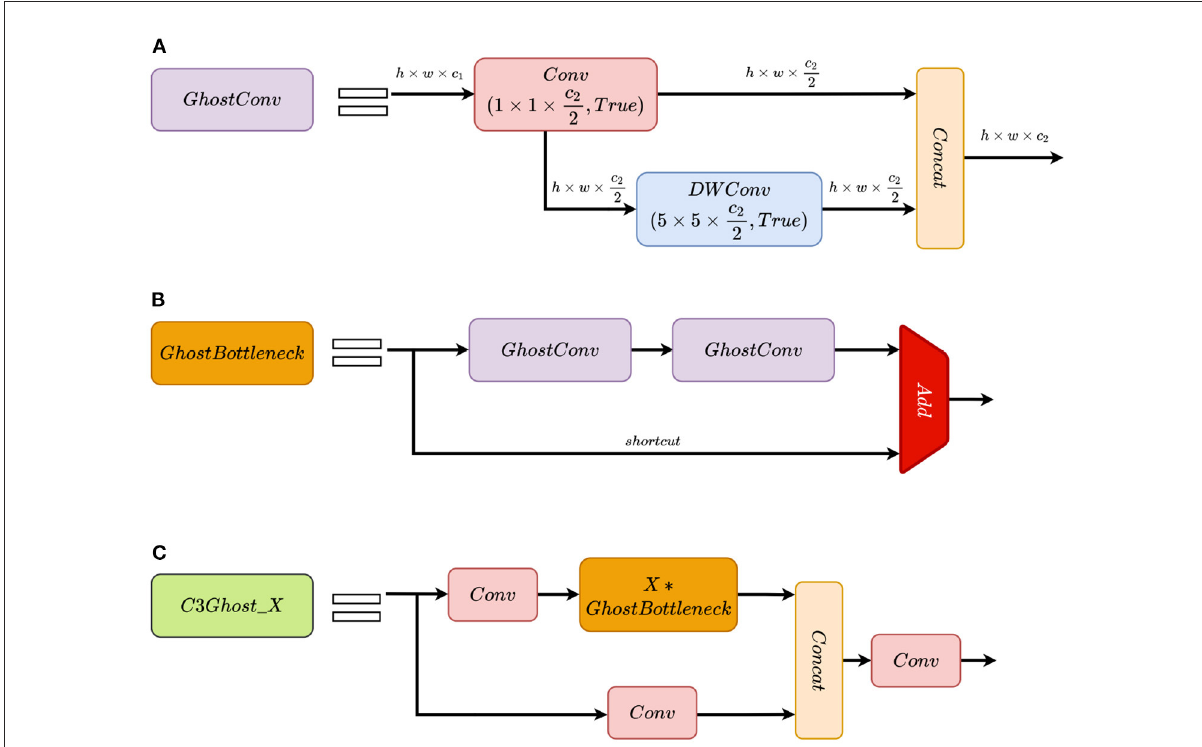
FIGURE3 Structures of the Ghost module, the Ghost Bottleneck module, and the C3Ghost_X module. (A) GhostConv represents the Ghost module. The h w c 1 data are first given to the 1 1 c 2 / 2 Conv module as an input to generate h × w × c 2 × × × × feature maps. Finally, the output feature maps from Conv and DWConv are concatenated to obtain DWConv module to obtain h × w × c 2 2 h w c 2 outputs. “True” indicates activation function is enabled. (B) GhostBottleneck is a residual block with two stacks of GhostConv and an × × identity shortcut from input. The output features are sum of the data from two paths above. (C) C3Ghost_X is the counterpart of C3_X module. Except that GhostBottleneck replaces Bottleneck, other parts are the same as